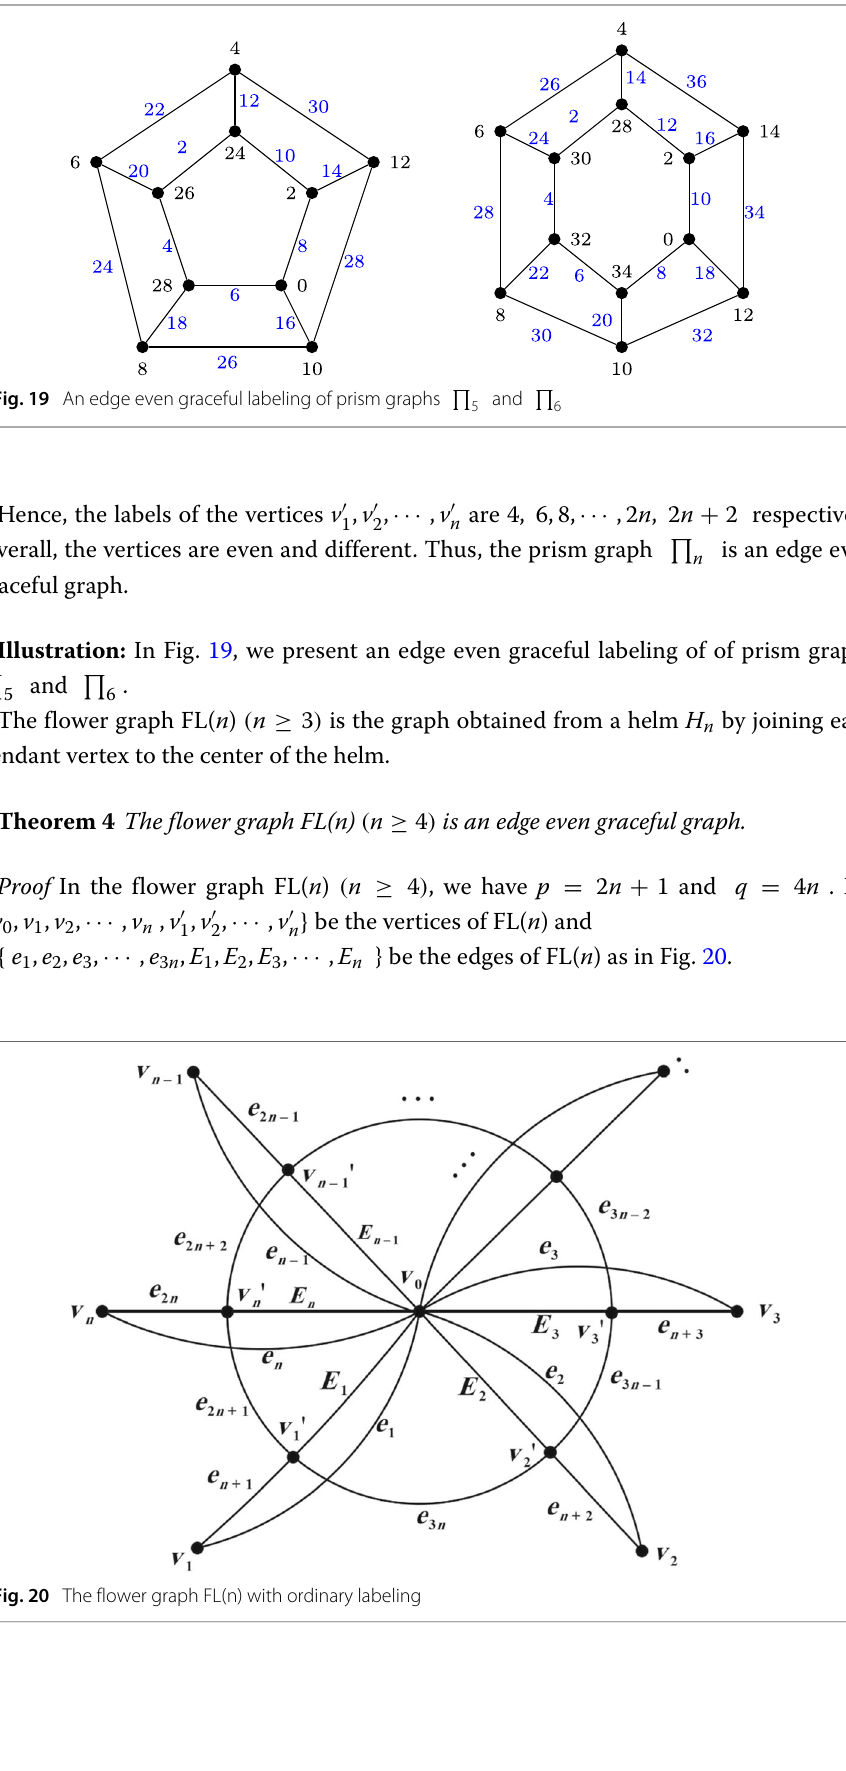
Fig. 19 An edge even graceful labeling of prism graphs